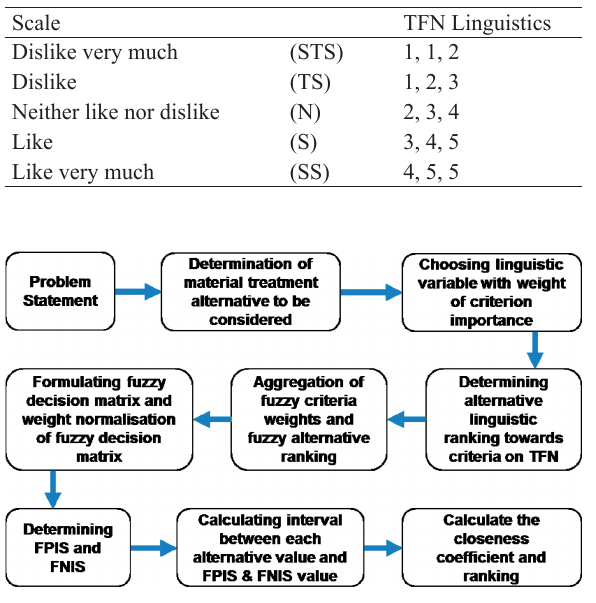
Figure 4 Steps of the fuzzy-TOPSIS method analysis